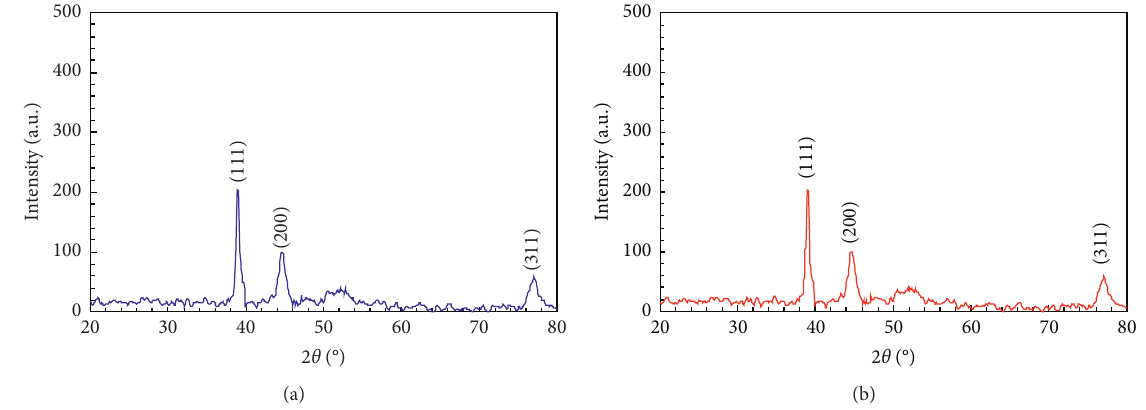
Figure 7: XRD pattern of the synthesized BCPE-AgNPs (a) and APE-AgNPs (b). Table 4: Cyclic voltammetry characteristics of aqueous black currant and apricot pomaces extracts.